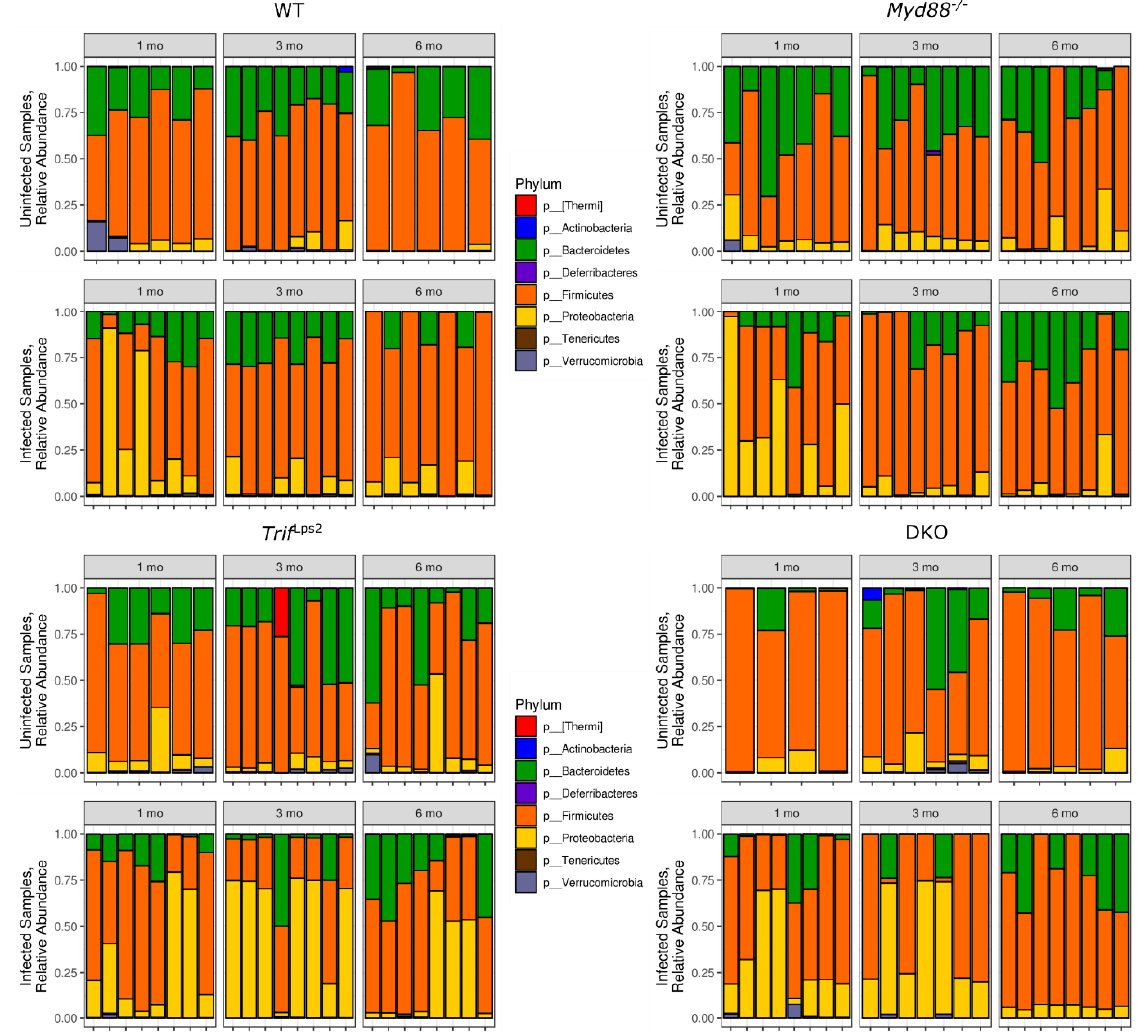
Figure 2. Relative abundance of different phyla across four genotypes. Relative abundance of individual phyla from WT, Myd88 − / − , Trif Lps2 , and double knockout (DKO) genotypes. The top eight phyla are shown in the legend. Samples are grouped into Helicobacter -infected and non- Helicobacter -infected and divided by time point. Sequencing data were processed in QIIME2, then plotted in PhyloSeq.